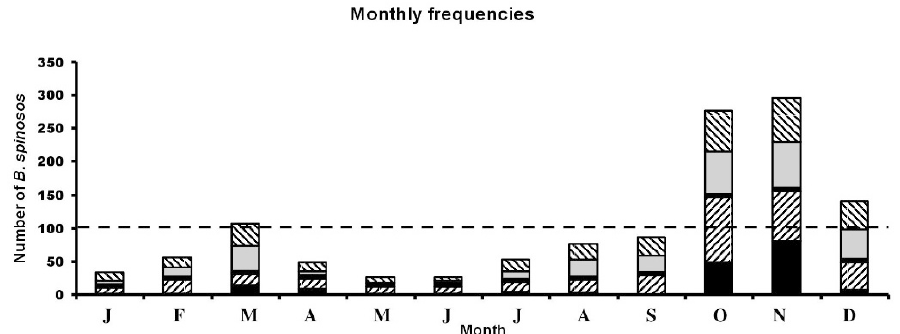
Figure 4. Monthly counts for all populations. Black bars indicate D949/ D764 area, grey D60, forward hatched D25 area and backward hatched D44/D127. The broken line indicates expected frequencies under a null hypothesis of equality of monthly counts. See text for other details.